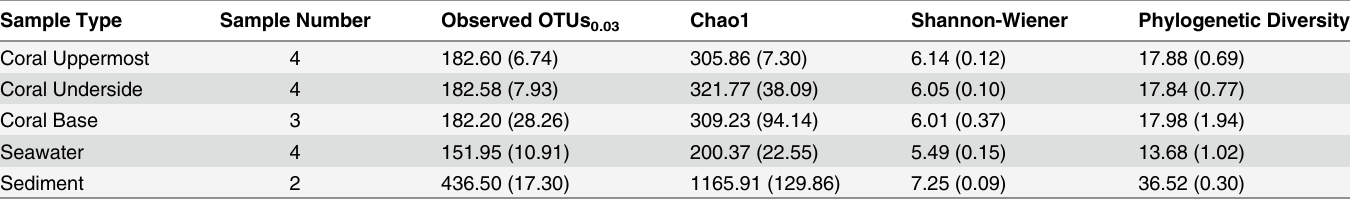
Table 1. Diversity by sample type at the rarefaction depth of 1158 sequences averaged for 10 random sequence subsets. Numbers within brackets indicate standard errors.